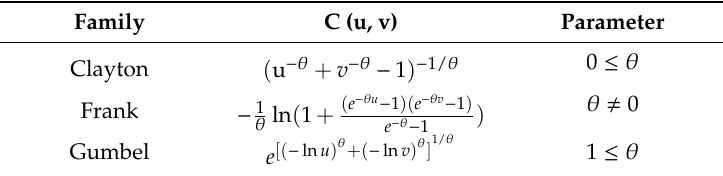
Table 1. Equations for the Archimedean Copula functions, where u and v are defined as two marginal distribution and θ is the dependence